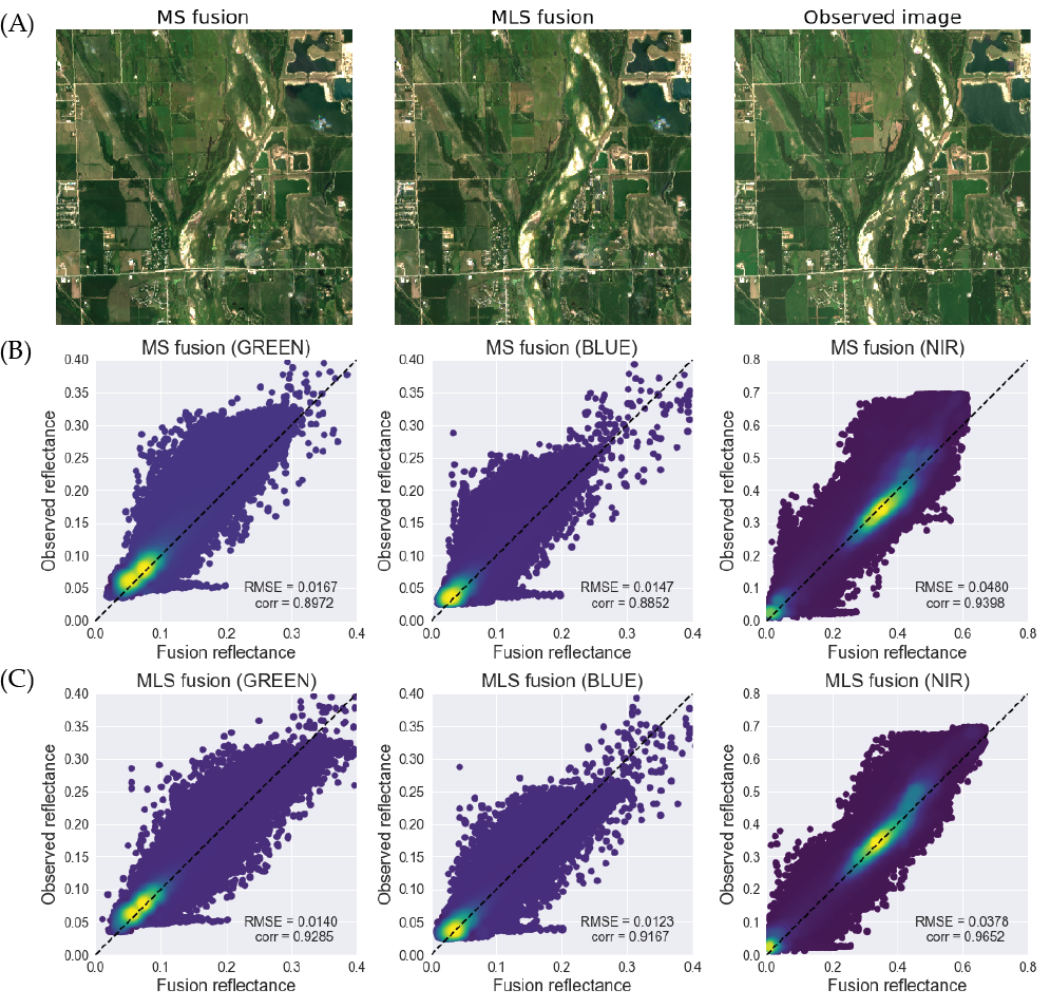
Figure 6. Visualization and evaluation of STAIR 2.0 fusion example. STAIR 2.0 was applied to produce a fusion image for an area in Saunders, NE, on 19 July 2017. The fusion image produced by MS fusion and MLS fusion are compared to the observed image, respectively. ( A ) RGB visualizations of MS (MODIS–Sentinel) fusion image, MLS (MODIS–Landsat–Sentinel) fusion image, and the observed image; ( B ) scatter plots of observed and fusion reflectance generated by MS fusion for green, blue and NIR bands; and ( C ) scatter plots of observed and fusion reflectance generated by MLS fusion for green, blue and NIR bands.